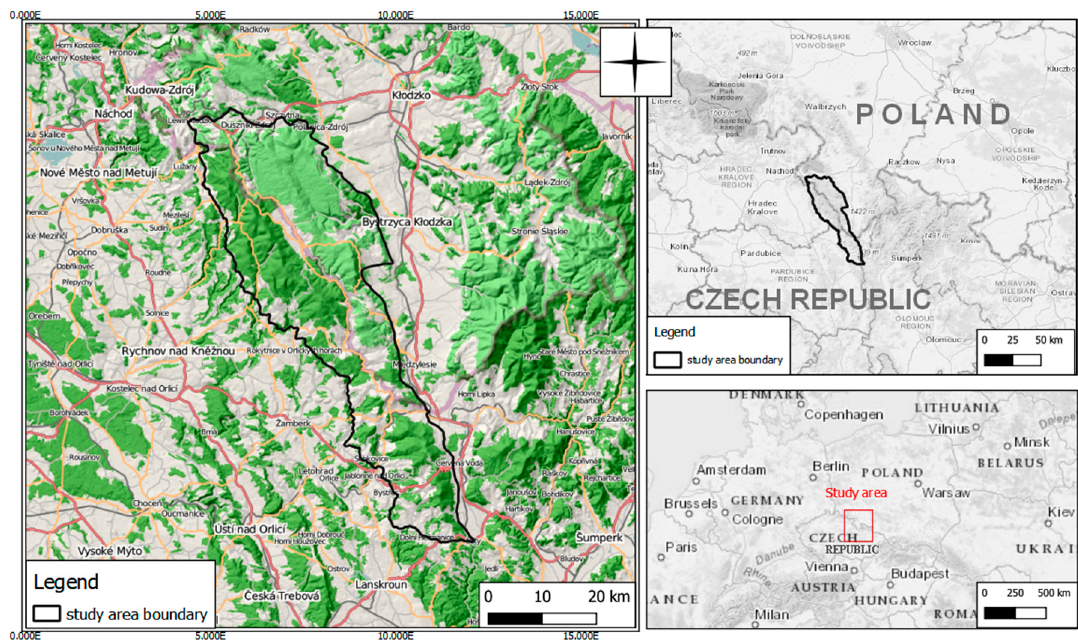
Figure 1. The location of the area under study.